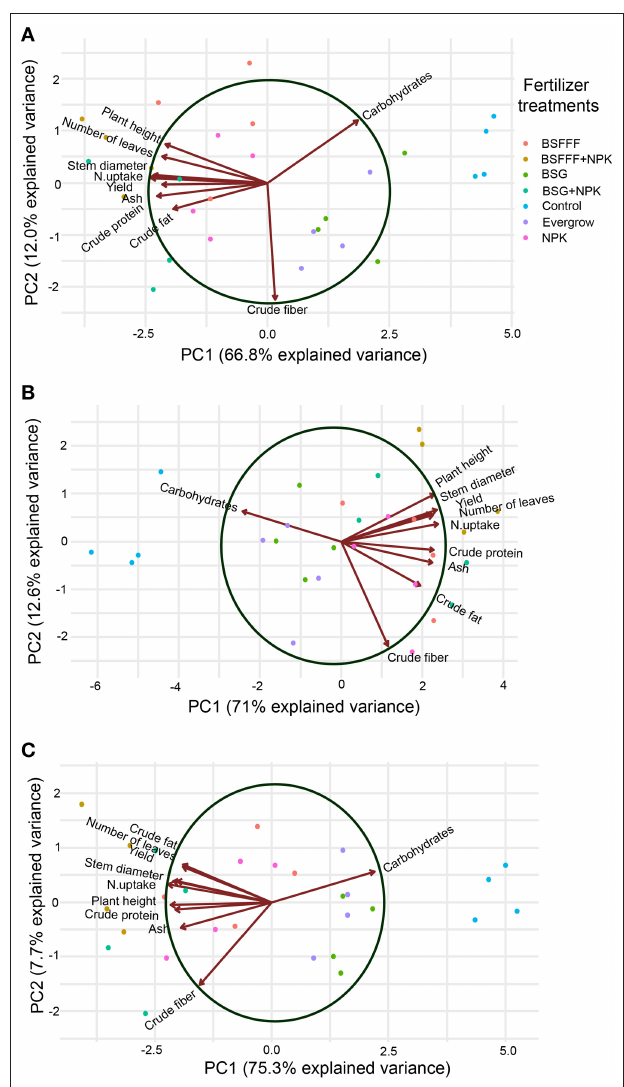
FIGURE 2 | Biplot graphs based on the PC analysis of parameters that measure (A) tomato, (B) kale and (C) French bean growth, yield, and nutritional quality as a function of the different fertilizer treatments. BSFFF, black soldier fly frass organic fertilizer applied at sole rate equivalent to 371kg N ha − 1 ; BSG, conventional compost from brewer’s spent grain applied at sole rate equivalent to 371kg N ha − 1 ; NPK, commercial mineral fertilizer applied at sole rate equivalent to 371kg N ha − 1 ; Evergrow, commercial organic fertilizer applied at sole rate equivalent to 371kg N ha − 1 ; BSFFF + NPK, combined application of BSFFF and NPK so that each supplies 185.5kg N ha − 1 ; BSG + NPK, combined BSG compost and NPK so that each supplies 185.5kg N ha − 1 , control, unfertilized